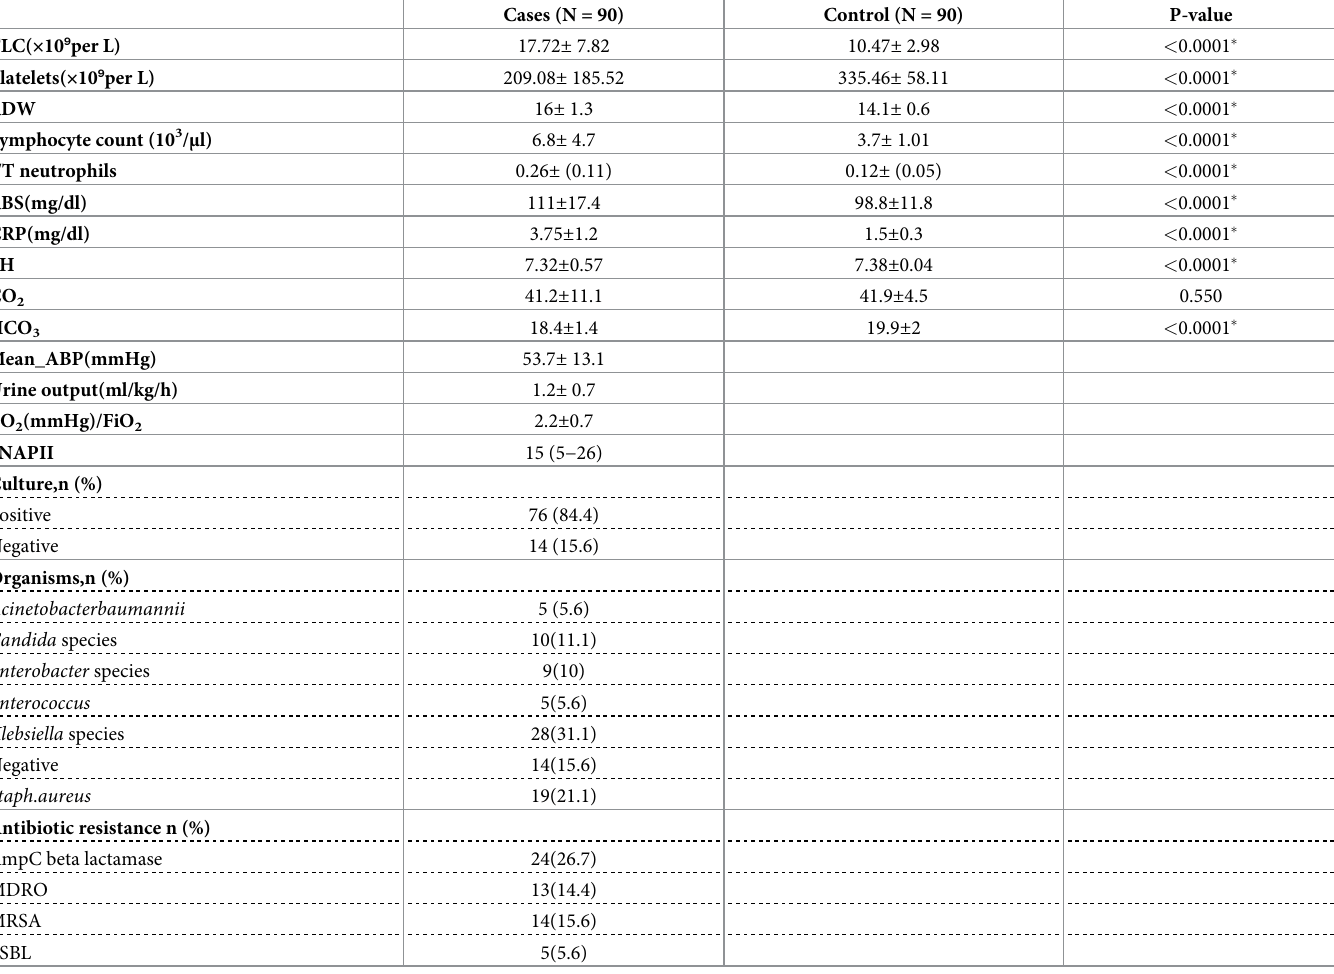
Table 2. Laboratory data of neonates with sepsis and control